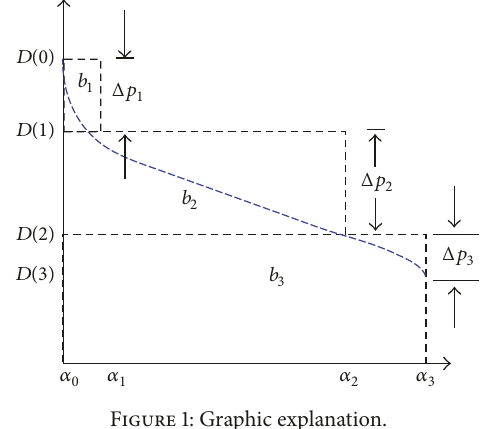
Figure 1: Graphic